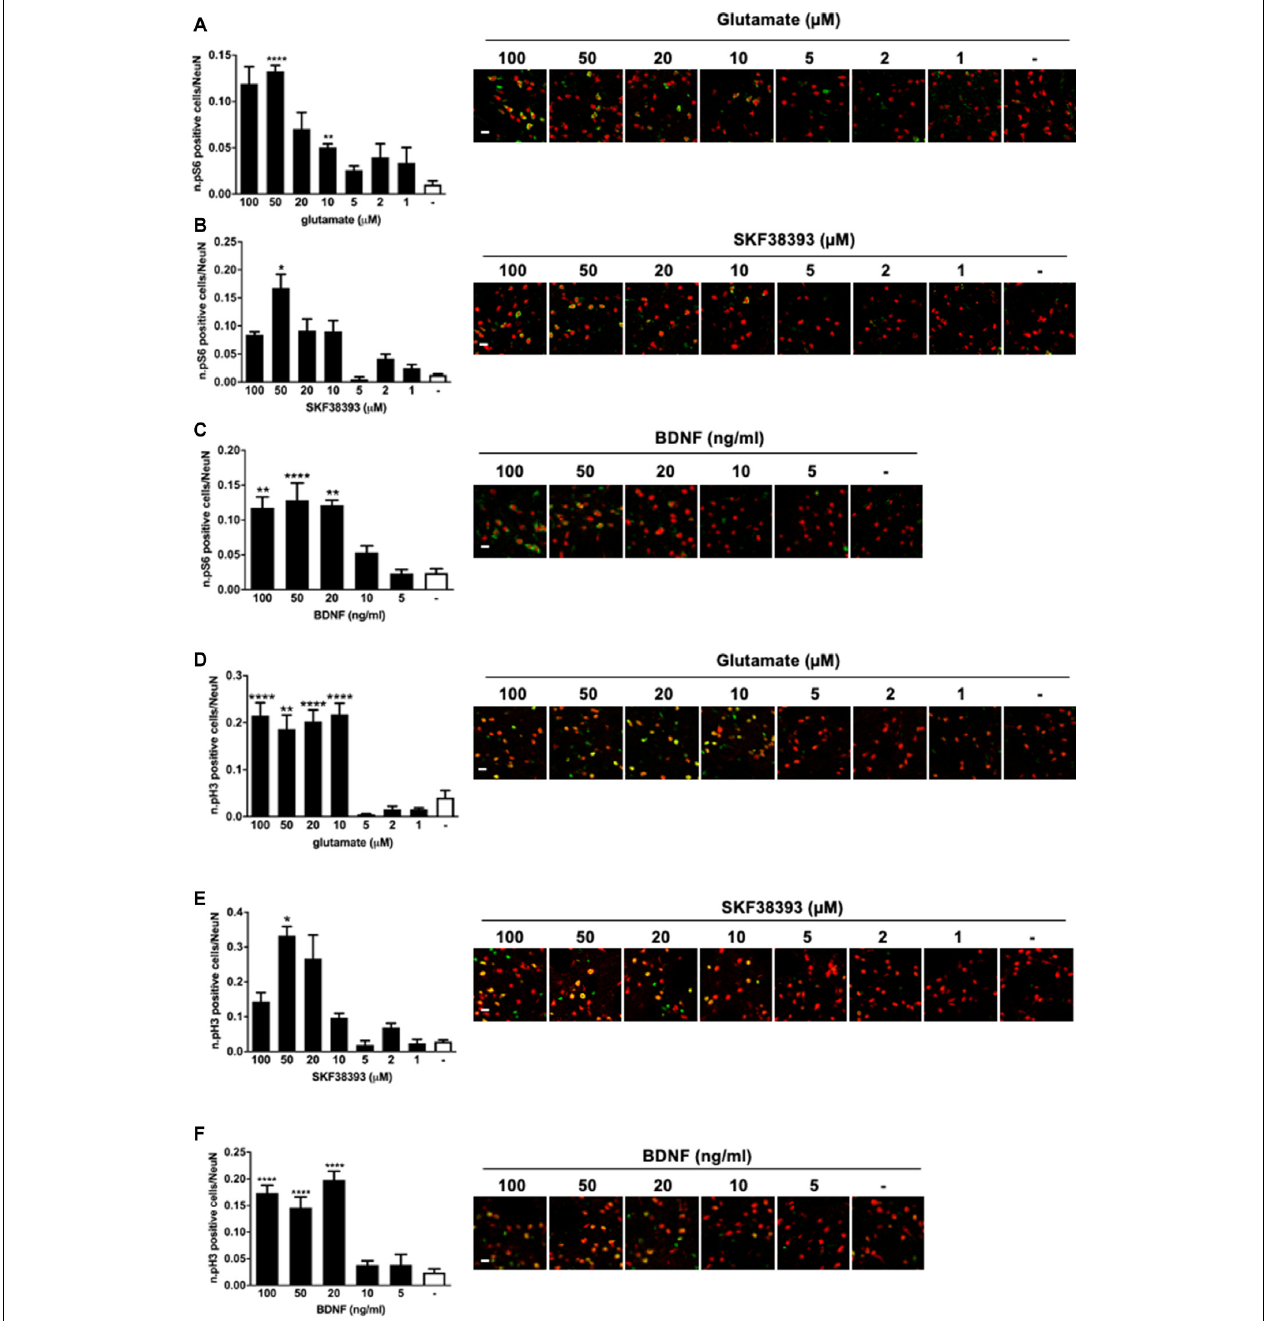
FIGURE 2 | (A) Glutamate induces phospho-S6 activation at the doses of 50 and 10 µ M (one-way ANOVA, Welch’s F (7,10.078) = 29.488, p < 0.0001. Games Howell’s post hoc : not stimulated vs. 50 µ M **** p < 0.0001, not stimulated vs. 10 µ M ** p < 0.01). Scale bar: 50 µ m. (B) SKF38393 50 µ M activates S6 (Kruskal–Wallis test, H (7) = 26.532, p < 0.0001. Pairwise comparisons: not stimulated vs. 50 µ M, * p < 0.05). Scale bar: 50 µ m. (C) BDNF activates S6 at doses ranging from 20 ng/ml to 100 ng/ml (one-way ANOVA, F (5,23) = 14.074, p < 0.0001. Bonferroni’s post hoc : not stimulated vs. 100 ng/ml ** p < 0.01, not stimulated vs. 50 ng/ml **** p < 0.0001, not stimulated vs. 20 ng/ml ** p < 0.01). Scale bar: 50 µ m. (D) Glutamate induces phospho-H3 at doses ranging from 10 to 100 µ M (one-way ANOVA, Welch’s F (7,9.401) = 25.373, p < 0.0001. Bonferroni’s post hoc : comparisons were made between the not stimulated condition and each glutamate dose: **** p < 0.0001, ** p < 0.01). Scale bar: 50 µ m. (E) H3 is phosphorylated by SKF38393 50 µ M (Kruskal–Wallis test, H (7) = 27.273, p < 0.0001. Pairwise comparisons: not stimulated vs. 50 µ M, * p < 0.05). Scale bar: 50 µ m. (F) BDNF activated H3 at doses ranging from 20 to 100 ng/ml. One-way ANOVA, F (5,23) = 26.854, p < 0.0001. Bonferroni’s post hoc between not stimulated conditions and each BDNF dose: **** p < 0.0001). Scale bar: 50 µ m. In all graphs, data are shown as mean ± SEM, n = 4 per group. In the representative pictures, the red channel (NeuN) is merged with the green channel (phospho-H3 or phospho-S6).